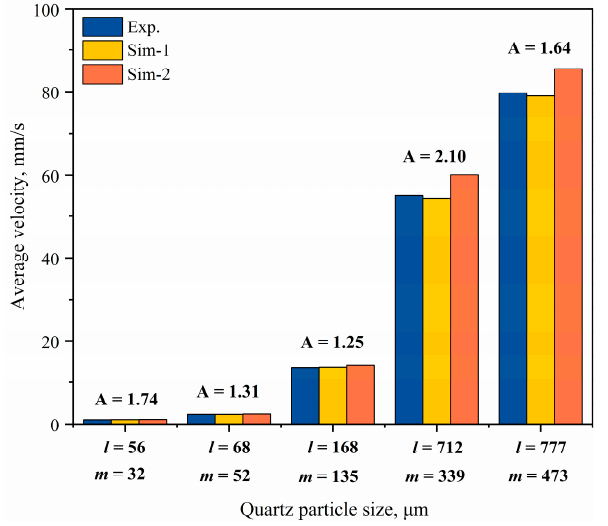
Figure 5. Comparison of experimental data and numerical simulation of sedimentation equilibrium velocities of different long–middle axis ratios.